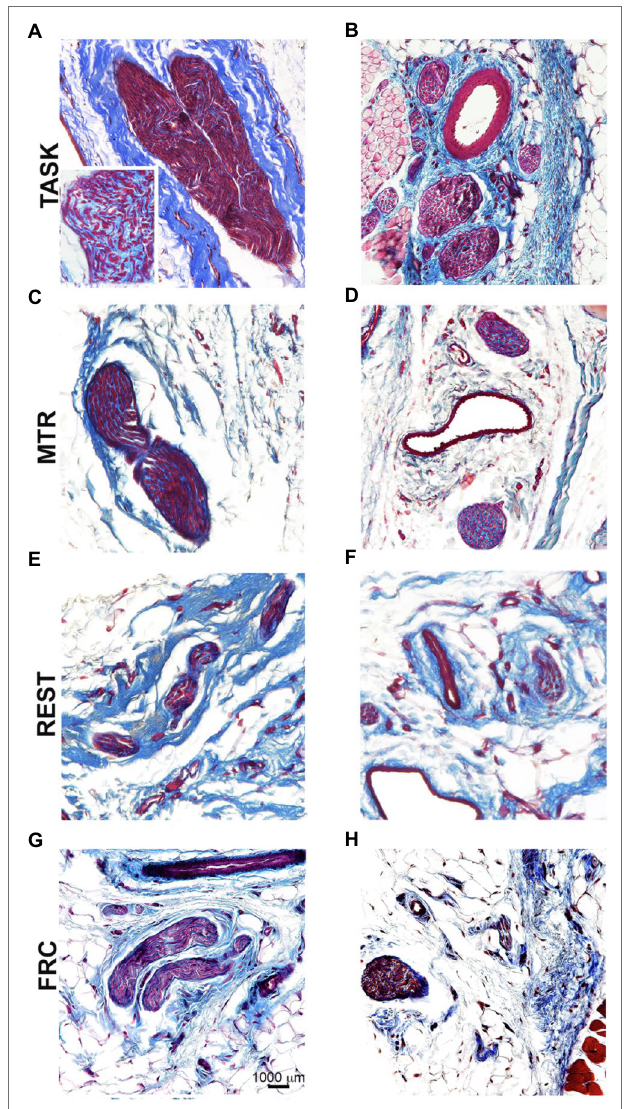
FIGURE 7 | Masson’s Trichrome staining for collagen in and around median nerves at wrist level. Left panels (A,C,E,G) : Representative images of longitudinal sections of the median nerve. Right panels (B,D,F,H) : Representative images of cross-sections of the median nerve. Scale bar in panel G = 1,000 μ m and applies to the other